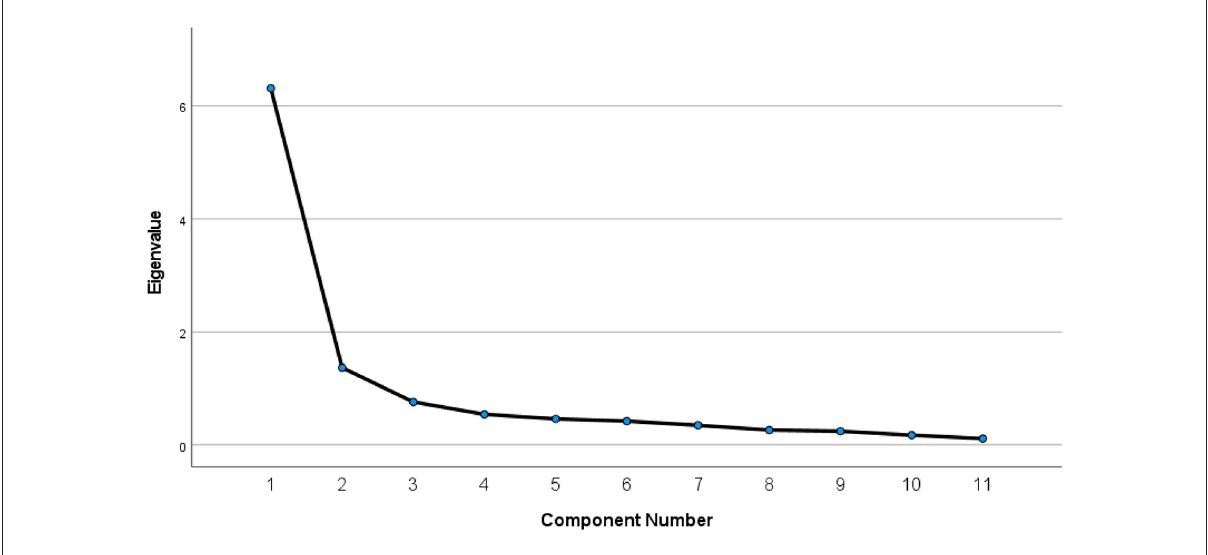
FIGURE2 Scree plot for police